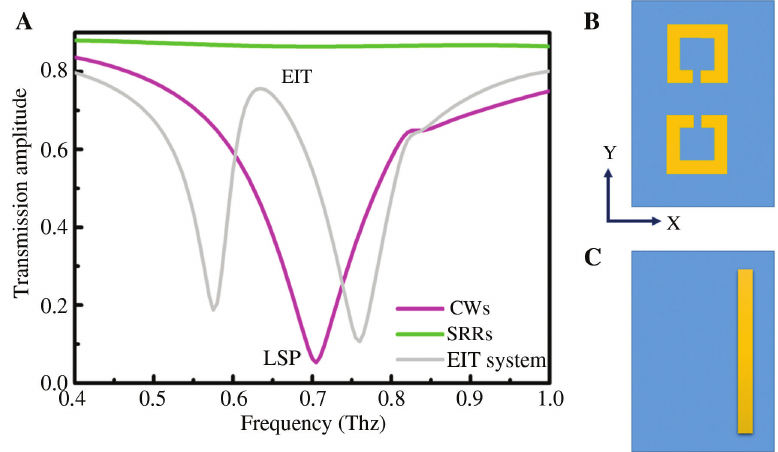
Figure 2: Simulated transmission spectra without excitation. (A) Simulated amplitude transmission property of the sole CWs, SRRs, and the EIT metamaterial sample. (B) and (C) are the structural geometries of the SRRs pair and CW, respectively. Corresponding to the illustration, the incident THz electric fields is polarized in the Y